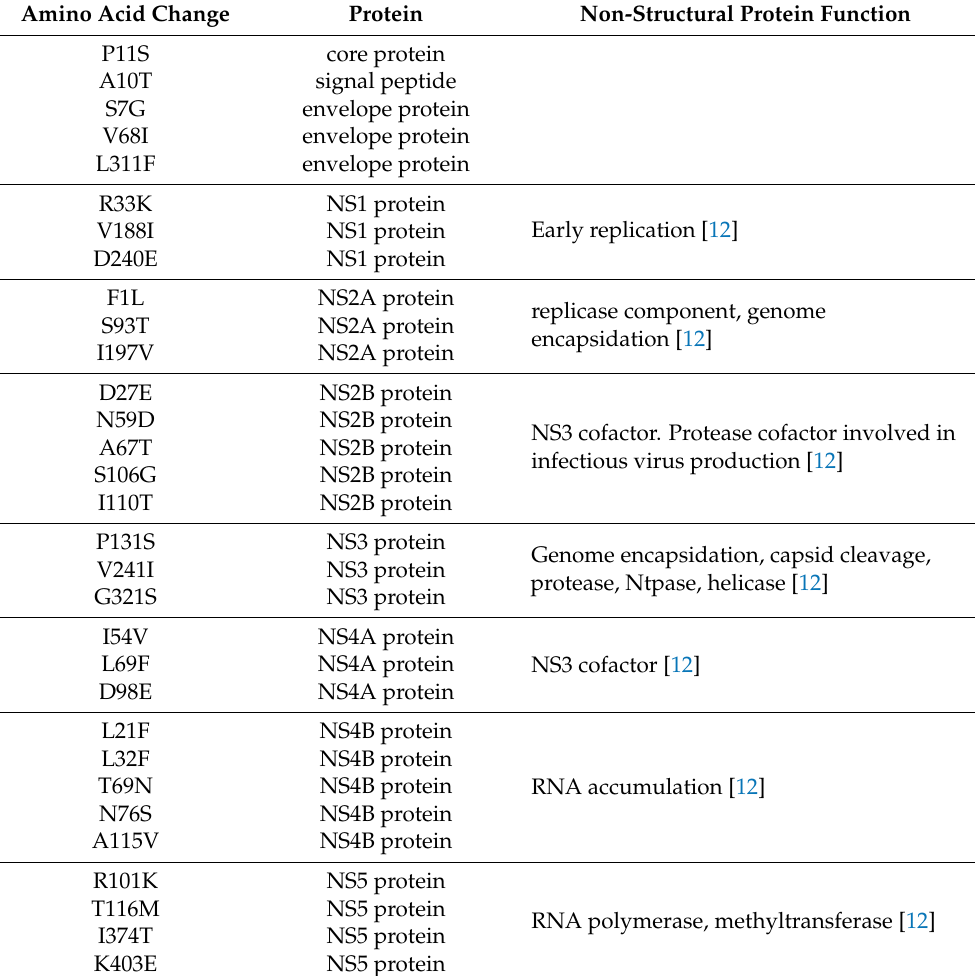
Table 1. Comparison of VIDRL-MVE to the G2 reference strain MVE-OR156 indicating the 31 predicted non-synonymous amino acid